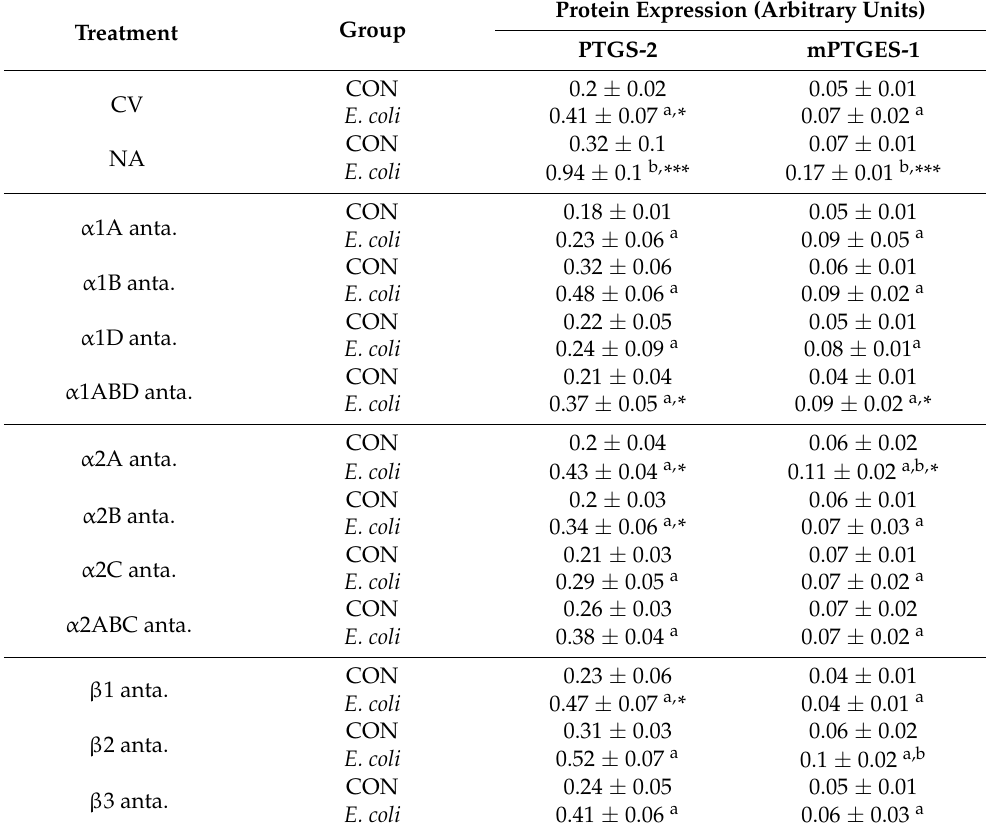
Table 1. Effects of noradrenaline (10 − 5 M) alone or antagonists of α 1-, α 2- and β -ARs (10 − 4 M) alone on the PTGS-2 and mPTGES-1 protein expression in the pig endometrium of the CON and E. coli groups, estimated by western blot method. Treatments were performed in triplicate for each of the five gilts in the individual groups. Values for PTGS-2 were normalized to glyceraldehyde-3-phosphate dehydrogenase (GAPDH), and values for mPTGES-1 were normalized to β -actin (ACTB). Representative bands of PTGS-2 and mPTGES-1 protein expression in untreated tissues and in response to noradrenaline are presented in Supplementary Figures S1 and S2, respectively. Data are expressed as the mean ± sem. Noradrenaline: NA; antagonist: anta.; control value: CV (untreated tissue). Protein Expression (Arbitrary Units) Treatment Group PTGS-2 mPTGES-1 CV